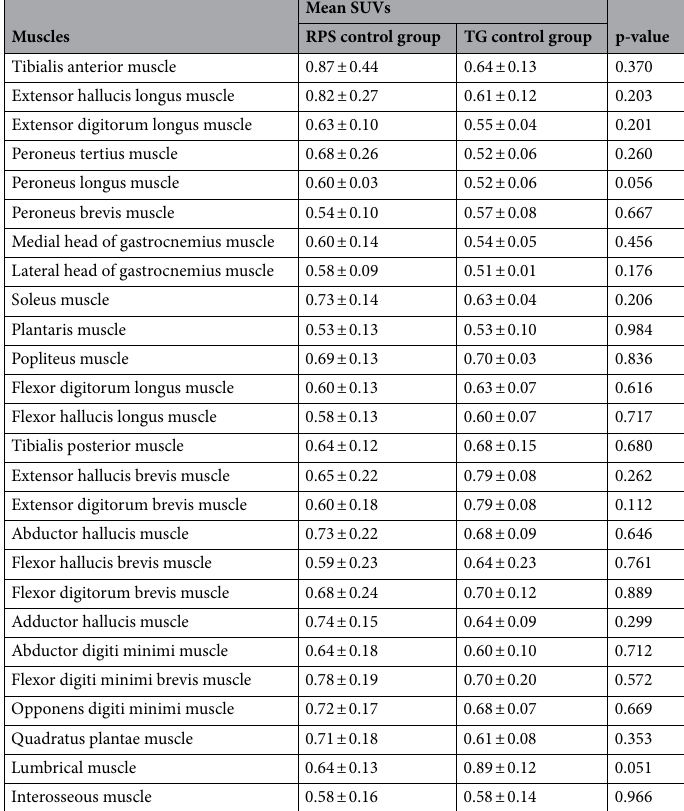
Table 4. Comparison of mean SUVs in the RPS control and TG control groups. Values are presented as the mean ± standard deviation. RPS: rock-paper-scissors; TG: towel gathering; SUV: standardized uptake value. The paired-samples t-test was used to evaluate differences in the mean SUV between the RPS control and TG control groups. Statistical significance was set at P <